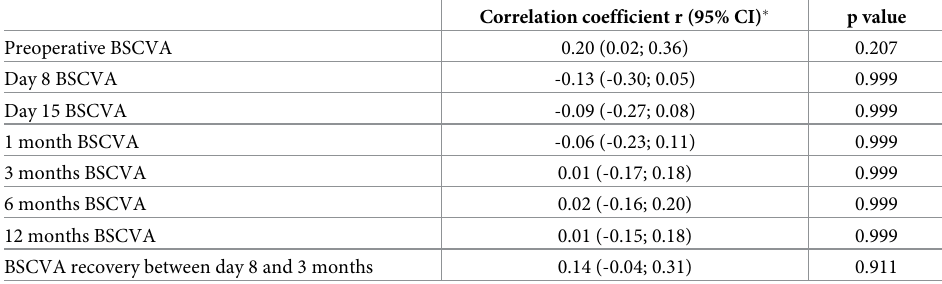
Table 3. Correlations of preoperative CCT with postoperative BSCVA or BSCVA recovery.